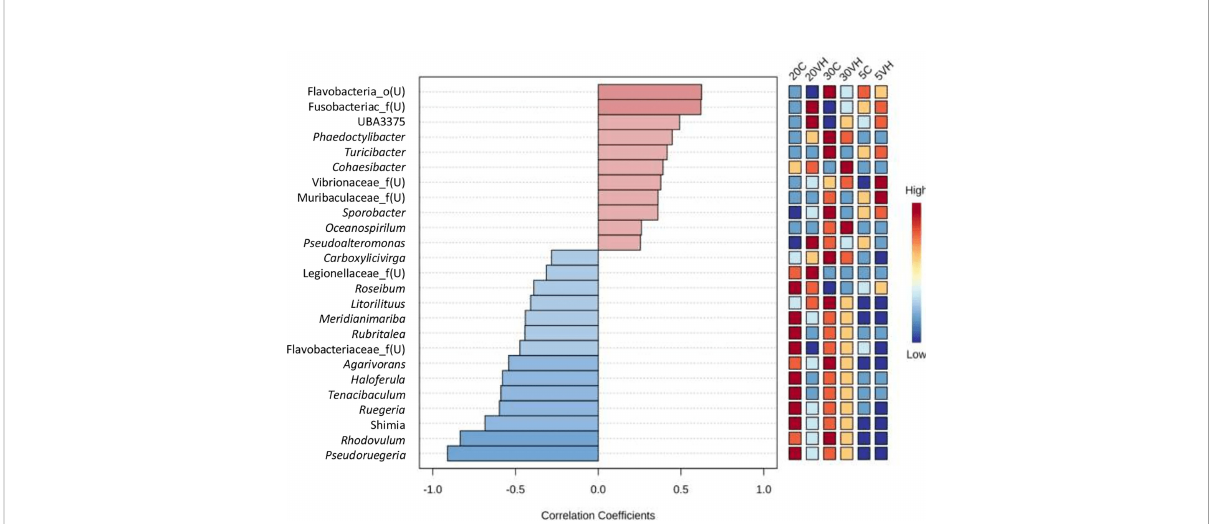
FIGURE 8 Top genus of gut microbiota in all Litopenaues vannamei correlated with the abundance of genus Vibrio . The blue bars indicated negative correlation between selected genus with genus Vibrio , whereas the pale red bars show positive interactions (VH, Vibrio harveyi infected group and C, Control group; 5, 5 ppt, 20, 20 ppt and 30, 30 ppt).